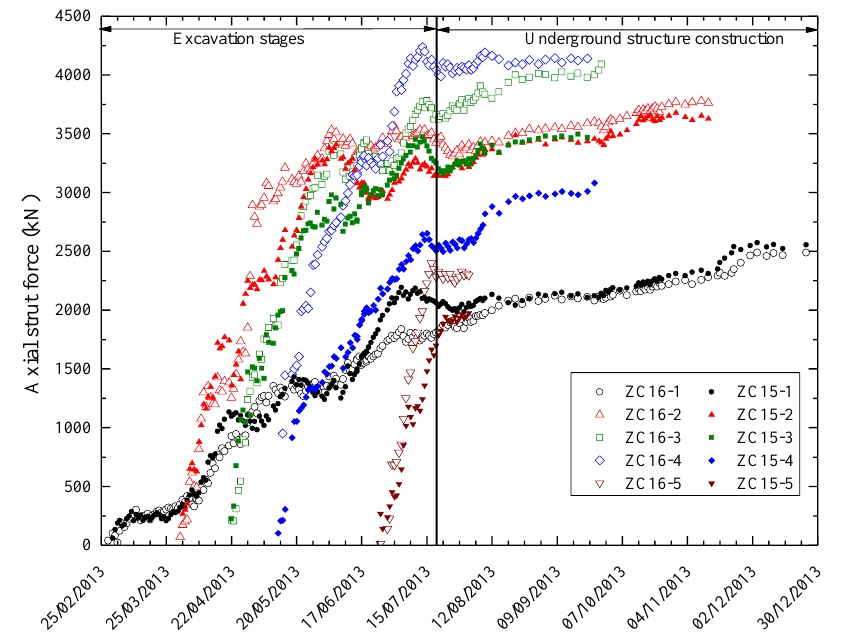
Figure 18. Developments of axial strut force at ZC15 and ZC16.